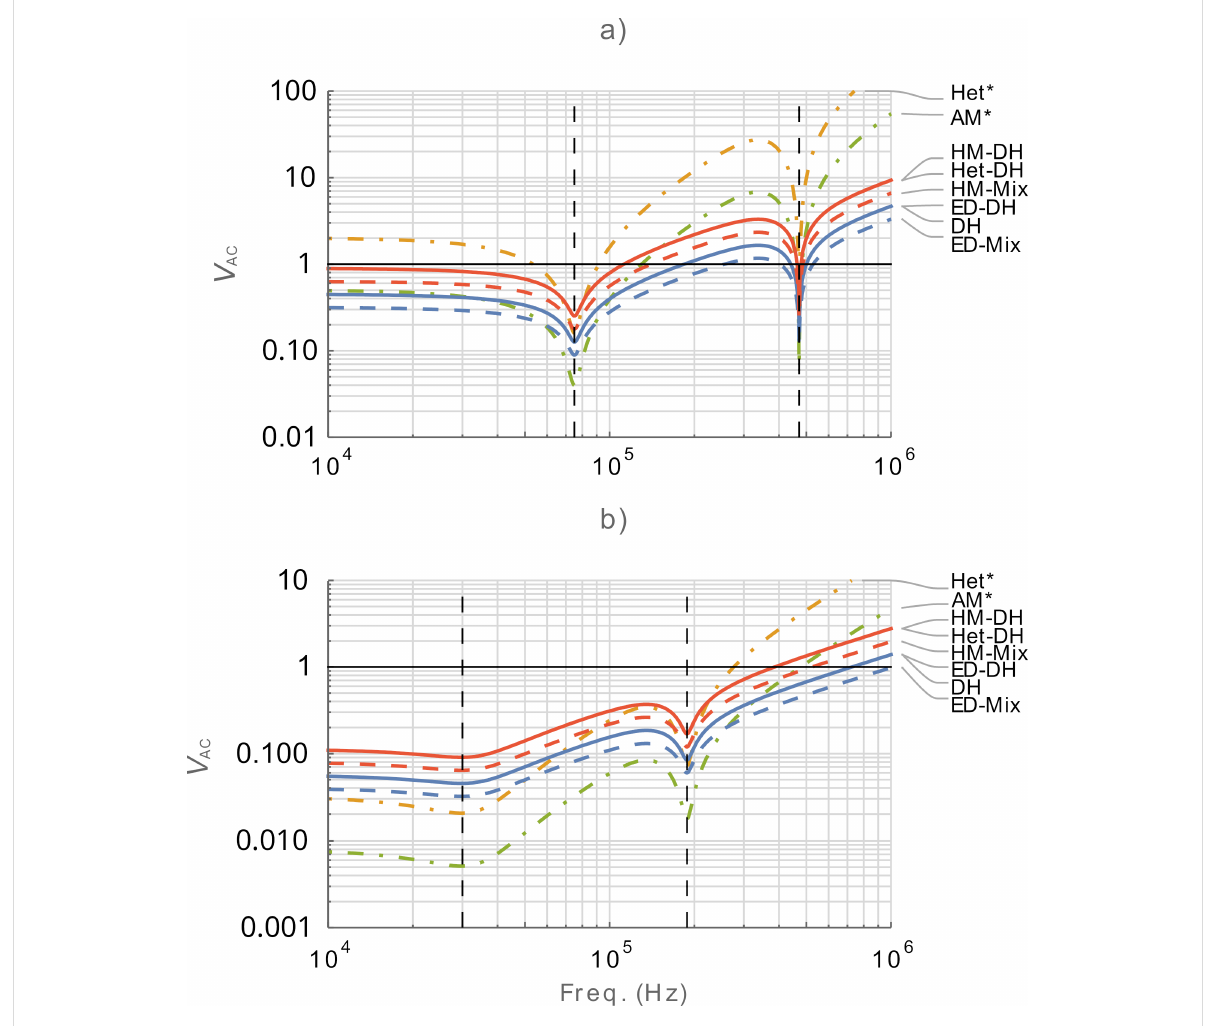
Figure 6: Comparison of the minimum AC bias required for operation, as a function of frequency in (a) air and (b) water. Calculations are made for z = 10 nm. The vertical dashed black lines indicate eigenmode positions. *Designated single-frequency modes. V CPD = 0.1 V for single fre- quency modes. The solid black lines indicate = 1.0 V. Lower values are better for all